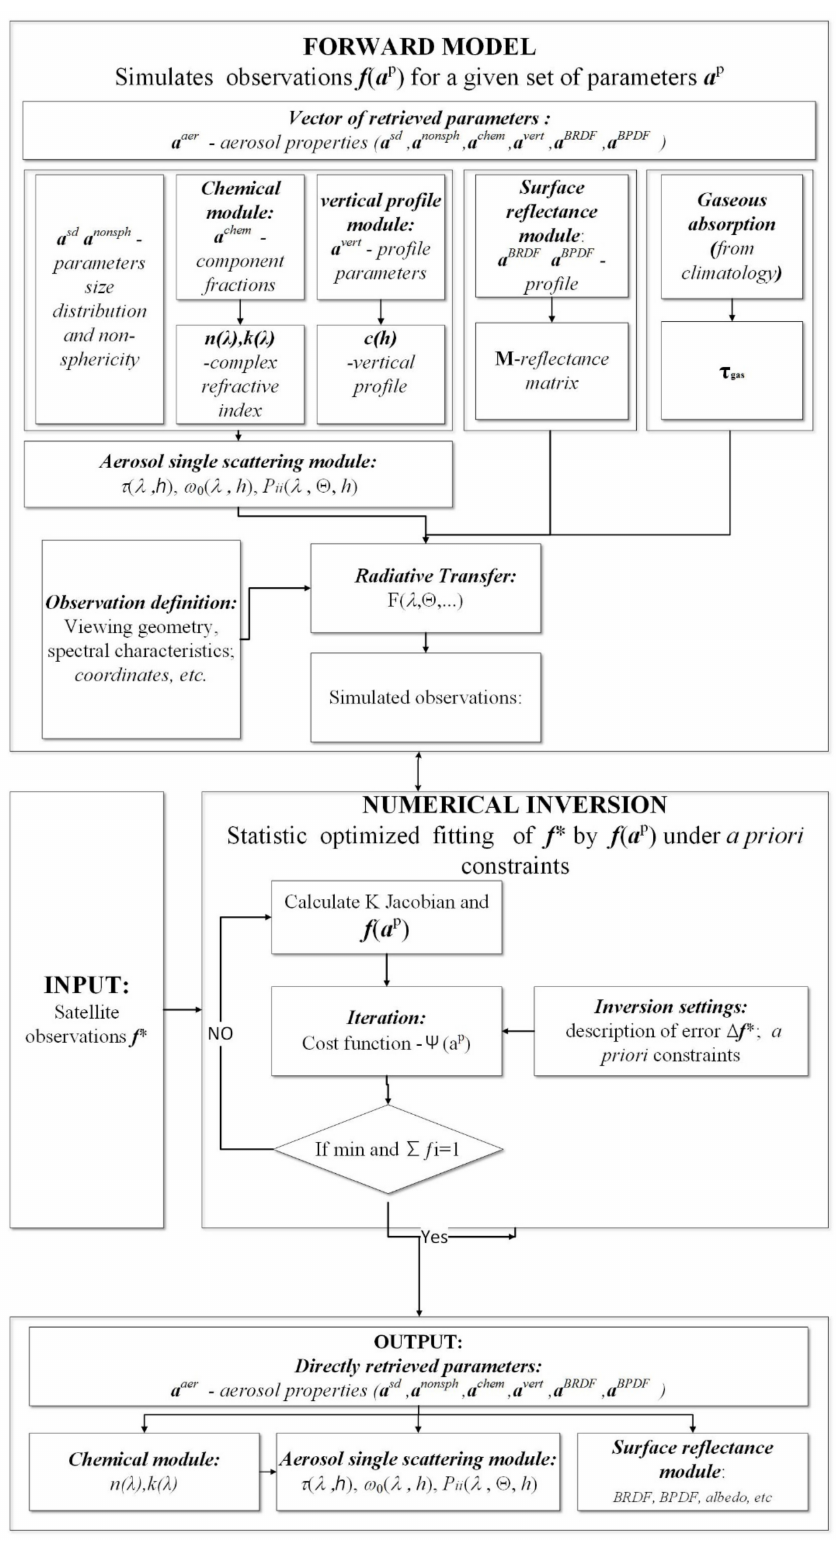
Figure 2. Flowchart of the main retrieval steps in GRASP algorithm. ( a chem —fractions of components; a sd —size distribution parameters; a nonsph —fraction of nonsperical particles; a vert —parameters of vert. profile; a BRDF —parameters of BRDF; a BPDF —parameters of